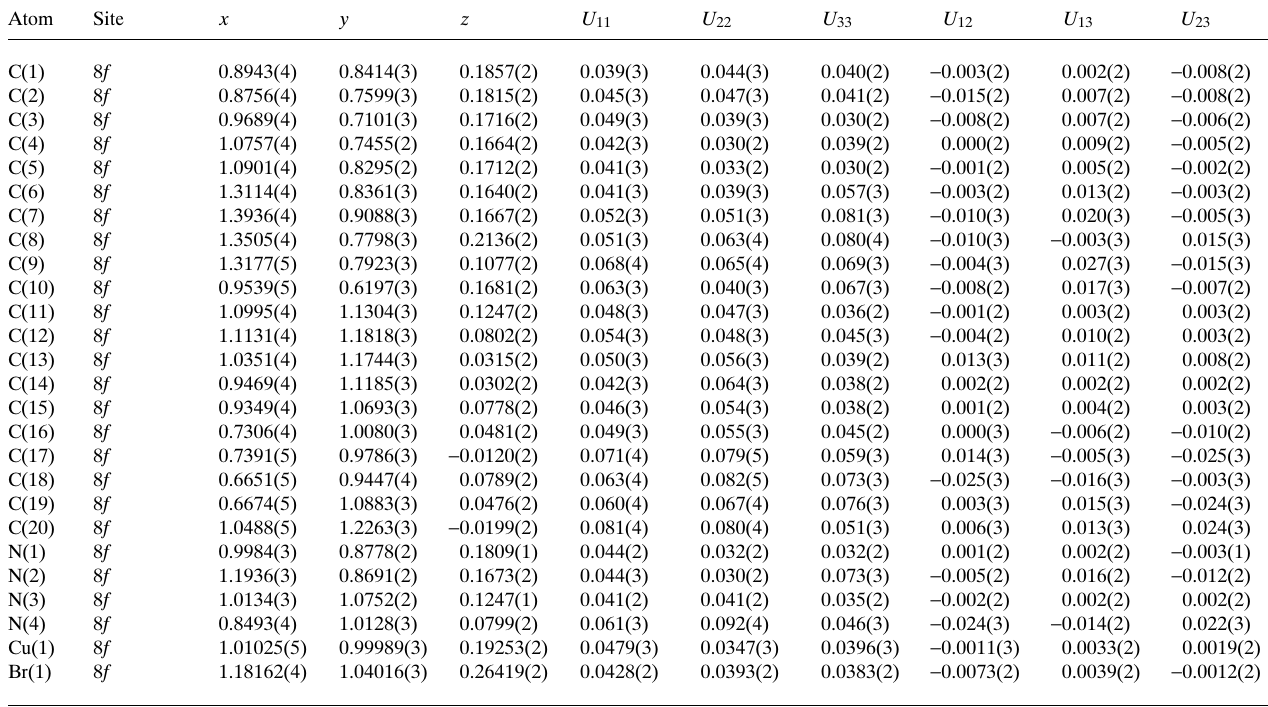
Table 3. Atomic coordinates and displacement parameters (in Å 2 ) .